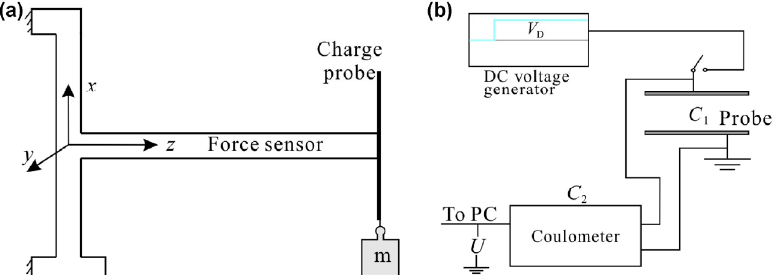
Fig. 2 Calibrations of sensor units. (a) A sketch illustrating the force calibrating method. (b) The calibrating method for the charge testing (adapted from the user’s manual) in which V D denotes supplied voltage and C 1 and C 2 denote the capacities of probe and coulometer, respectively. The total capacity and resistance of the system correspond to 100.072 nF and 0.6 Ω , respectively, and result in a time constant corresponding to 6.0042×10 − 8